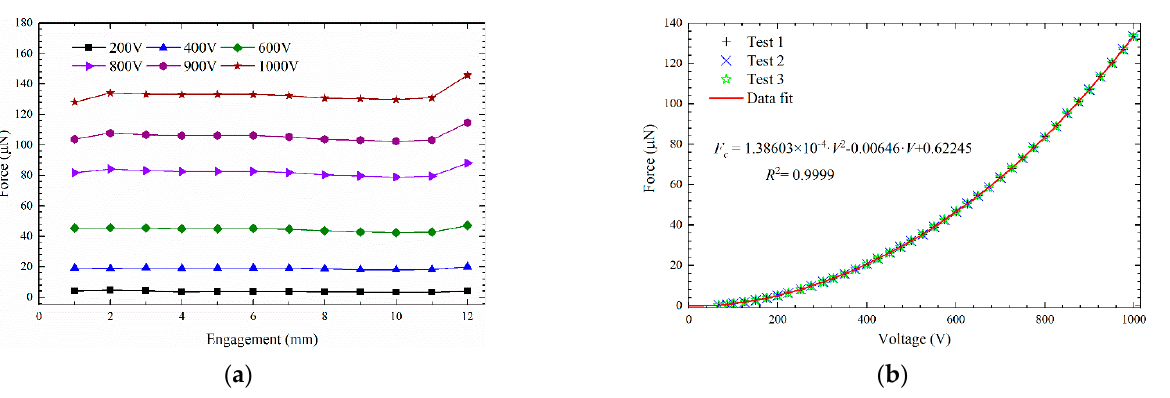
Figure 4. ( a ) The influence of engagement distance on electrostatic force, ( b ) fitting function for the calibration data at 6 mm engagement distance.